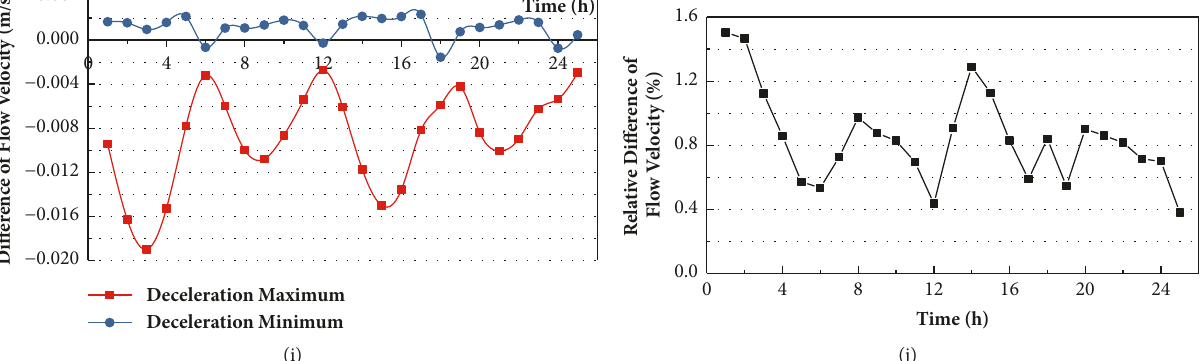
Figure14:Variationsinflowvelocityofcircumferencewithradiusof100